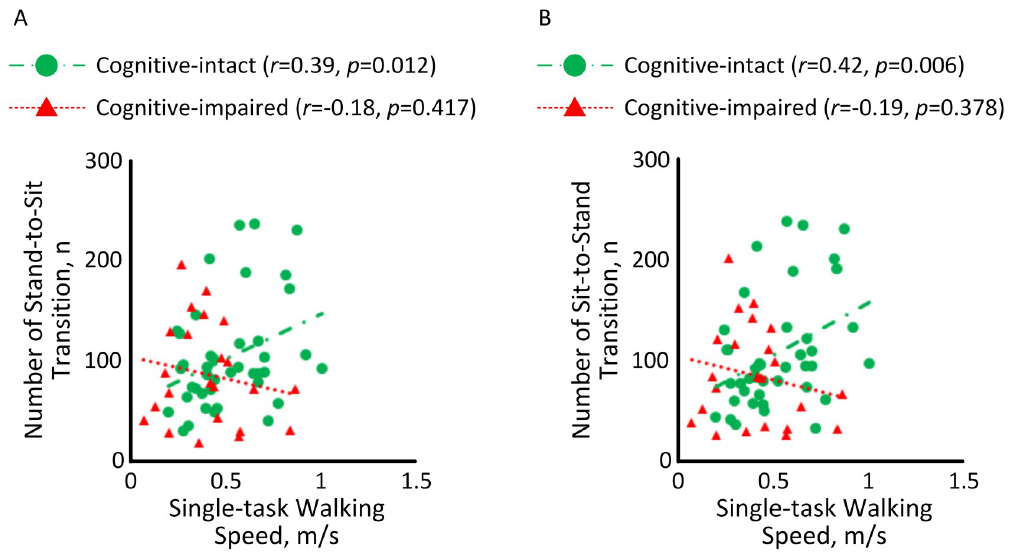
Fig 3. Correlations between single-task walking speed and (A) number of stand-to-sit transition and (B) number of sit-to-stand transition among HD patients with and without cognitive impairment. https://doi.org/10.1371/journal.pone.0225358.g003 Model 1 (demographics alone) was 0.76, with a sensitivity of 44.0%, specificity of 88.6%, and accuracy of 72.5% for predicting cognitive impairment. The AUC for Model 2 (demographics + daily walking performance) was 0.78, with a sensitivity of 44.0%, specificity of 79.5%, and